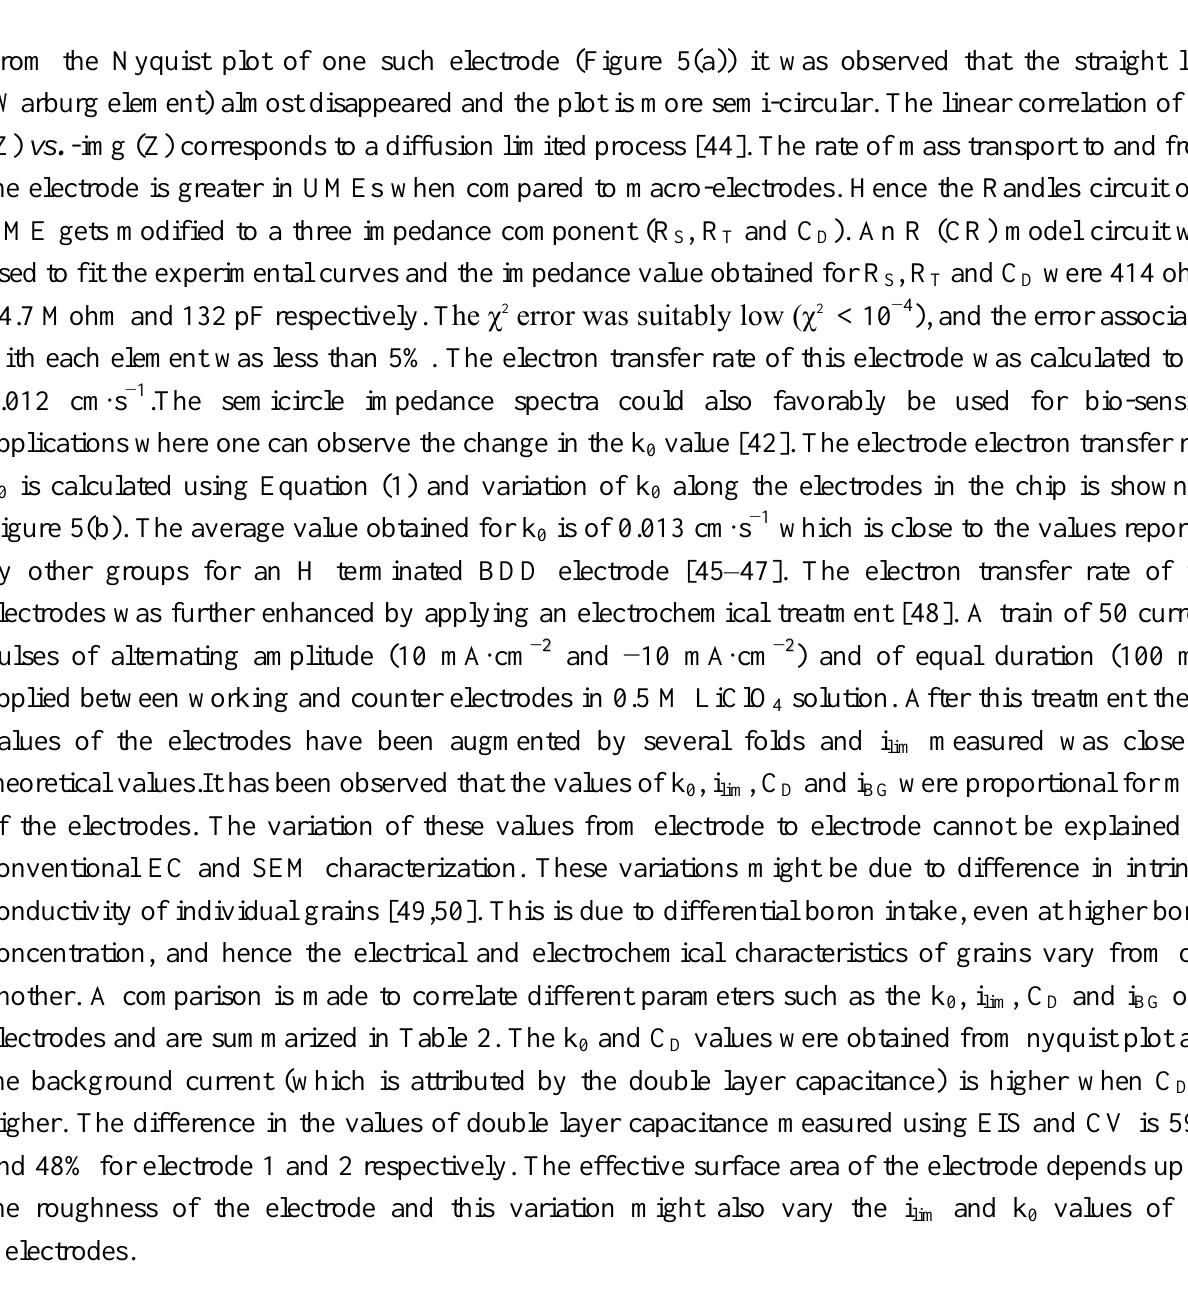
Table 2. Comparison of different parameters such as the electron transfer rate k